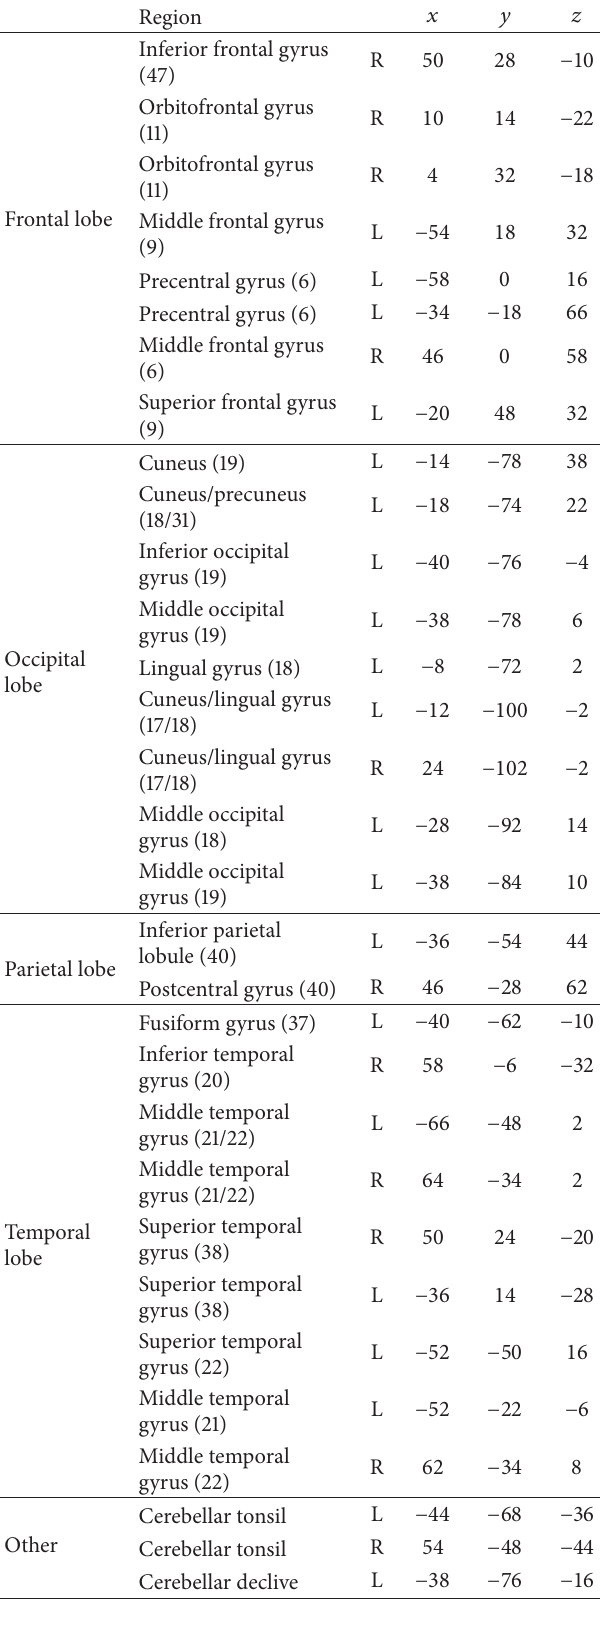
Table 3: Searchlight results for subsequent memory effects of fast